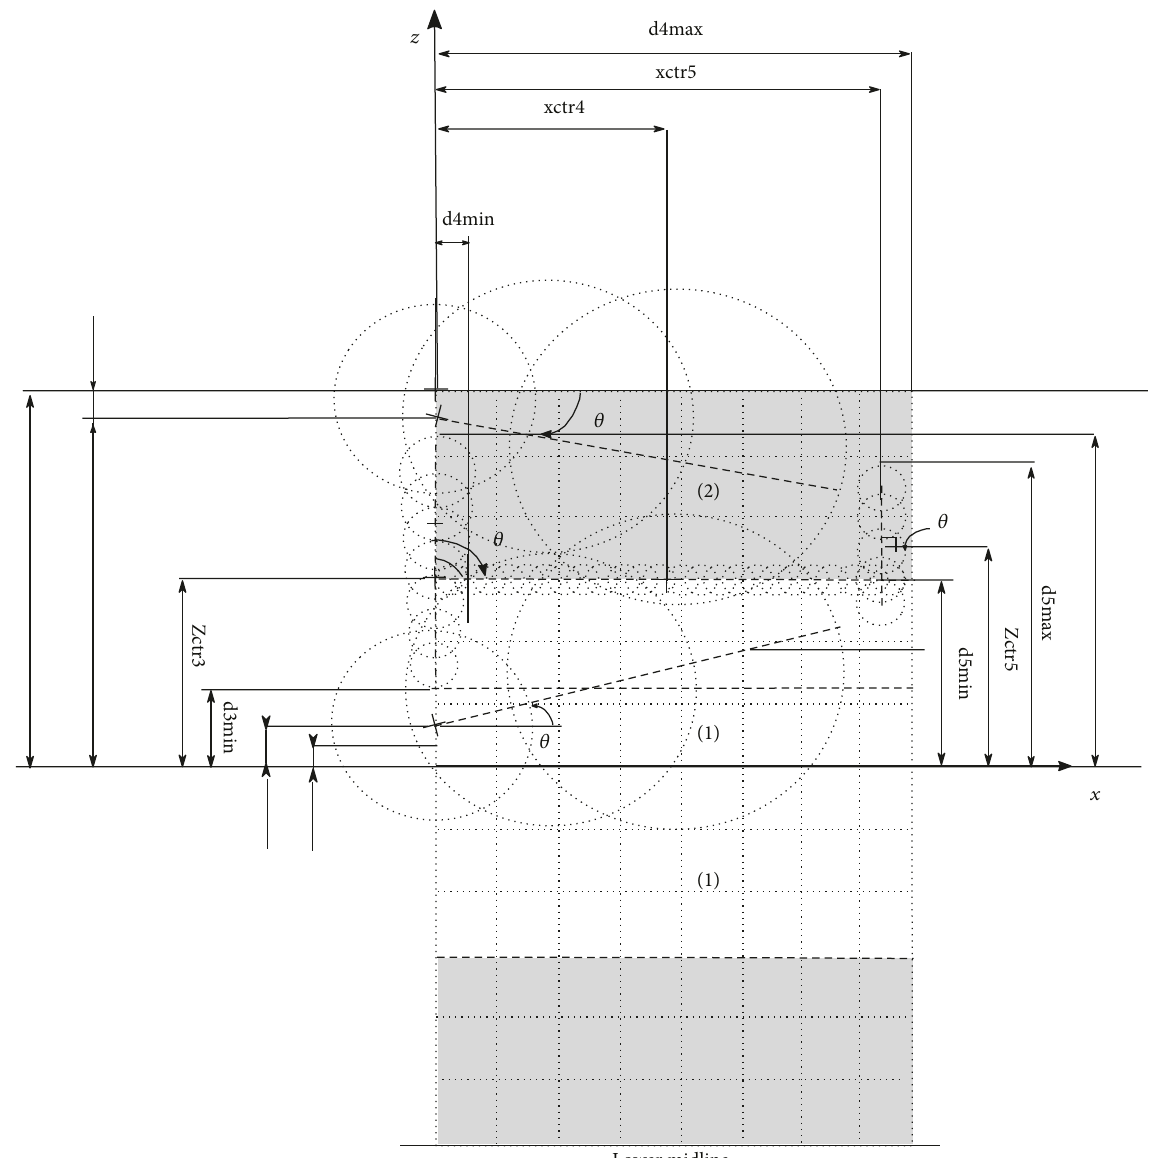
Figure 4: Arbitrary stick distribution with a longitudinal gradient onto the B-grid adopted for thermal protection system